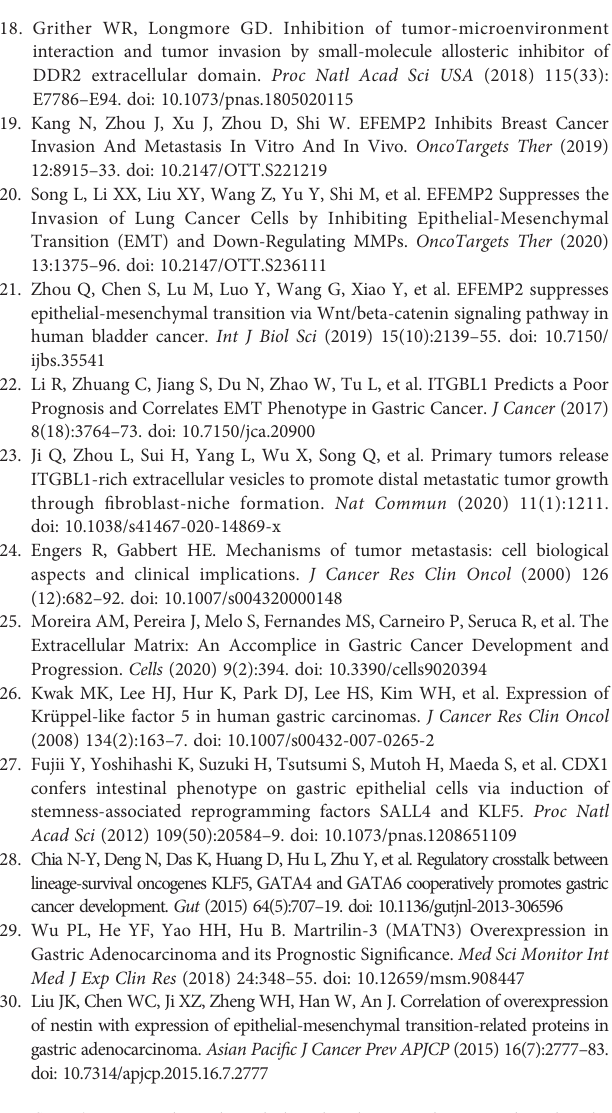
Supplementary Figure 2 | -S6 The relationships between the prognostic model and in fi ltration of six types of immune cells (B cells, CD4+ T cells, CD8+ T cells, neutrophils, macrophages, and dendritic cells), which are estimated by TIMER algorithm. FigureS2 , ARHGAP32; FigureS3 , KLF5; FigureS4 , MAMLD1; Figure S5 , MATN3; Figure S6 ,